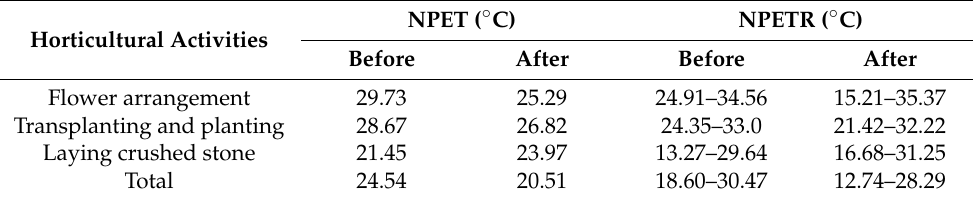
Table 8. NPET and NPETR at different horticultural activities.